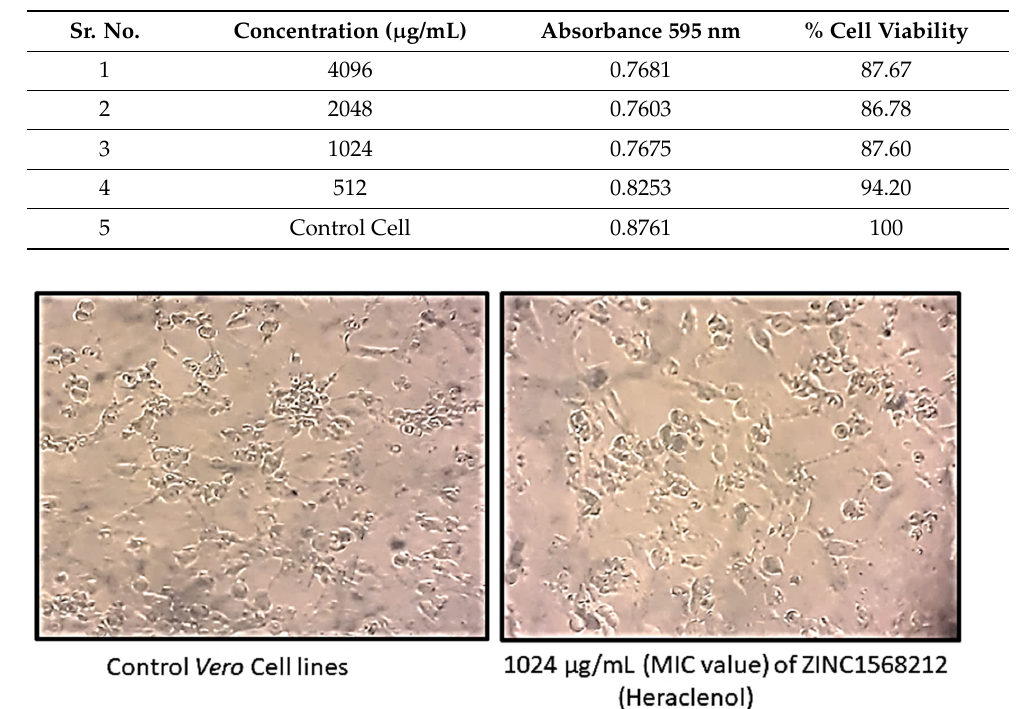
Figure 3. Heraclenol effectiveness in the clearance of UPEC infection from the bladder ( A ), kidney ( B ), and urine ( C ) in the in vivo mouse model. The statistical analysis was performed by using one- way ANOVA and Dunnett’s multiple comparison tests, * p , 0.05; ** p , 0.01; *** p , 0.001; NT—not tested (control), NS—nonsignificant. 3.2. Histopathology Analysis of Kidney Tissue Kidney tissues from uninfected mice and drug-only controls showed normal glomer- uli (Figure 4a,c), whereas, in the mice infected with UPEC, signs of severe inflammation, congestion, dilation of Bowman’s capsule, and widespread infiltration of neutrophils were observed (Figure 4b). When compared, the infected mice treated with a below MIC value showed mild inflammation and congestion (Figure 4d). In the MIC group, little vas- cular congestion was seen, and glomeruli looked normal (Figure 4e). Similarly, infected mice treated with the above MIC value of the drug heraclenol showed normal glomeruli with mild chronic inflammation (Figure 4f).